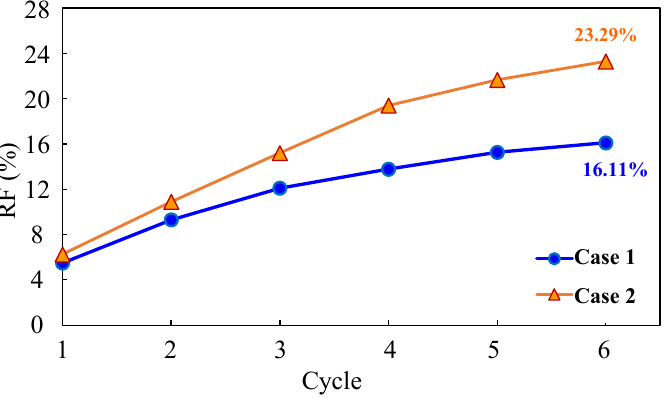
Figure 10. Recovery factor of case one and case two.